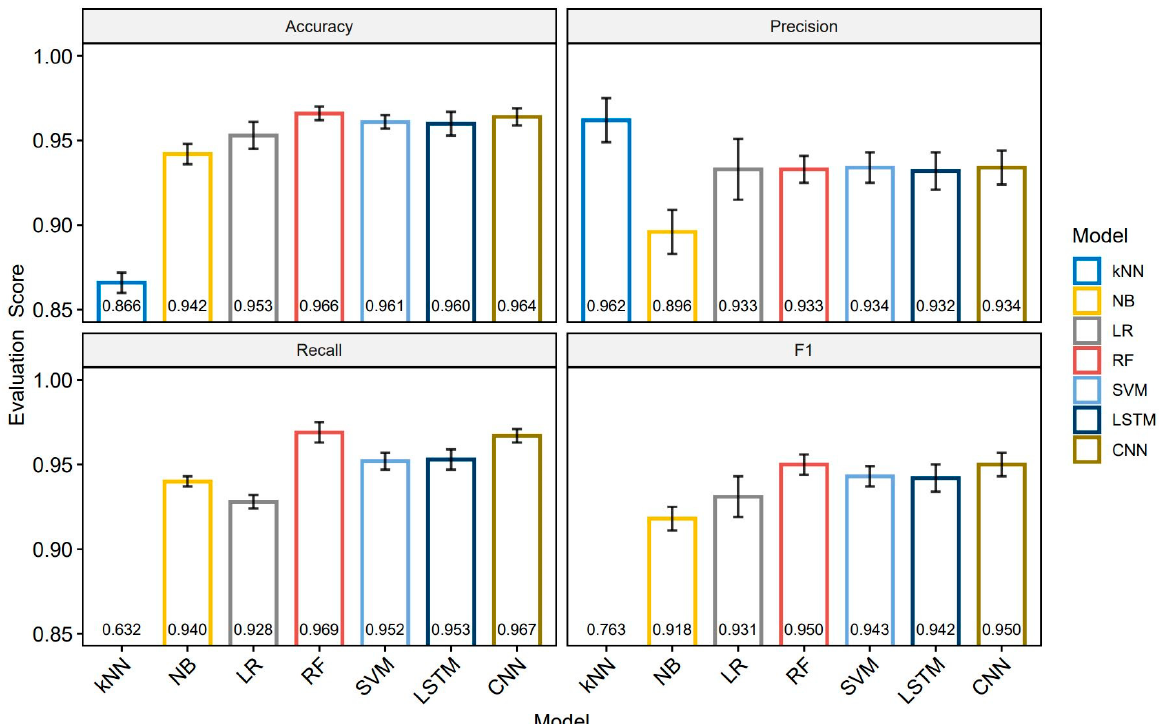
Figure 5. Model evaluation results after hyperparameter tuning and cross-validation (bars indicate standard deviations). Note: Although RF and CNN have the same F1 score (0.950), RF has a lower standard deviation (0.006 vs. 0.007).